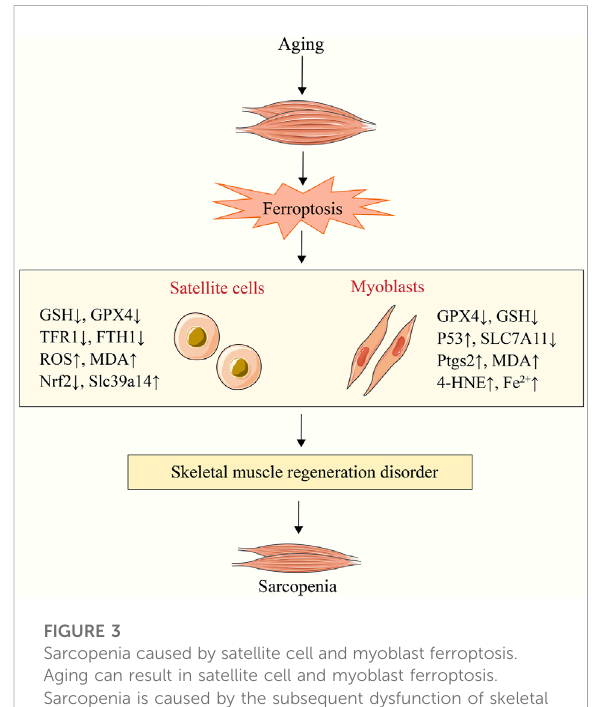
FIGURE 3 Sarcopenia caused by satellite cell and myoblast ferroptosis. Aging can result in satellite cell and myoblast ferroptosis. Sarcopenia is caused by the subsequent dysfunction of skeletal muscle regeneration. NADPH, nicotinamide adenine dinucleotide phosphate; Ptgs2, prostaglandin-endoperoxide synthase 2; 4-HNE, 4-hydroxynonenal; Slc39a14, zinc transporter Zip14; MDA, malondialdehyde; SLC7A11, solute carrier